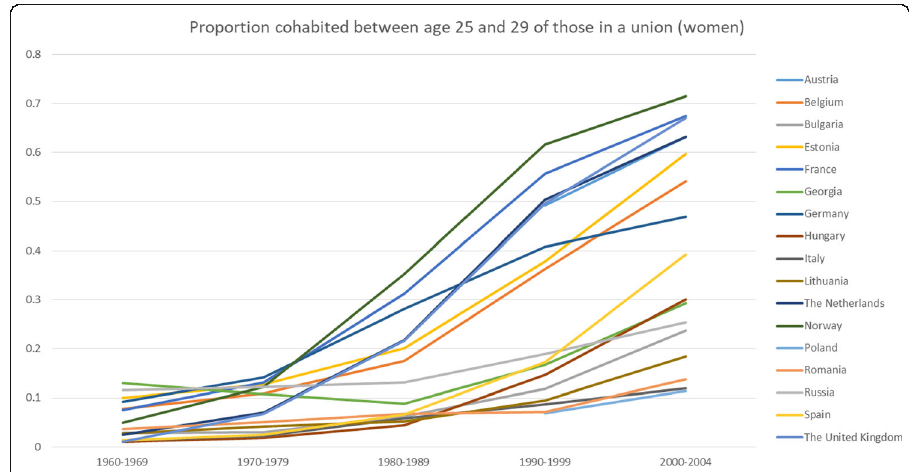
Fig. 5 Expansion of cohabitation in selected European countries: Proportion of women aged 25 – 29 who cohabited for at least 1 year relative to all women 25 – 29 who were in a union (married + cohabiting) for at least 1 year; 1960-2004. Source: Courtesy of Jorik Vergauwen, Antwerp University. Data: Gender and Generations Survey harmonised data and national